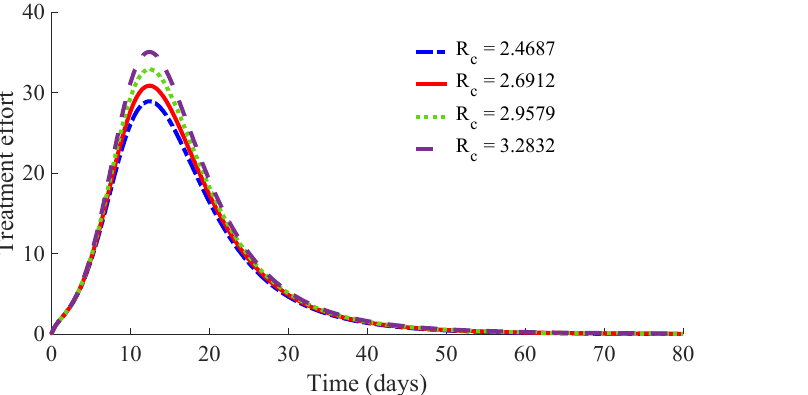
Figure 12. Time evolution of the treatment effort for the four considered values of the control parameter c 2 .